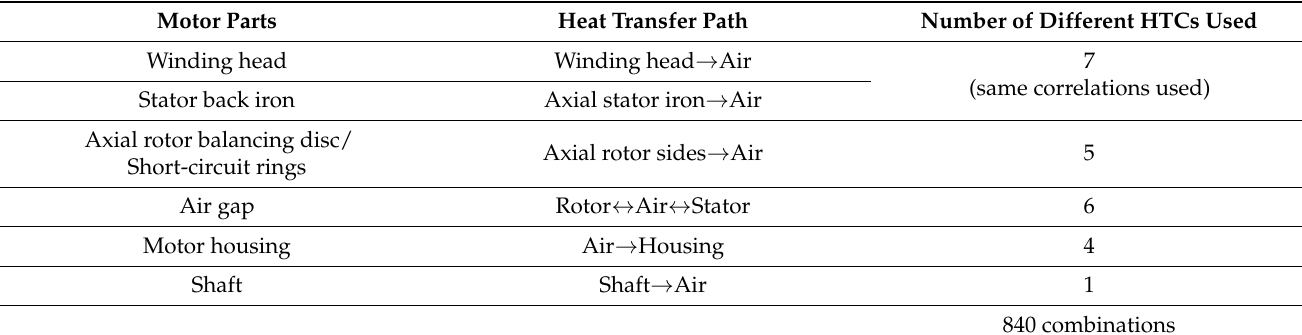
Table 2. Number of reviewed HTC correlations from the